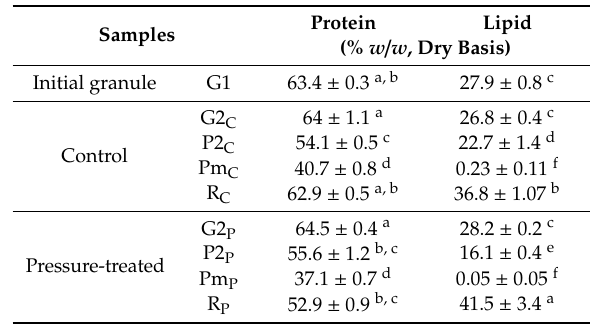
Table 1. Protein and lipid contents of control and pressure-treated fractions of egg